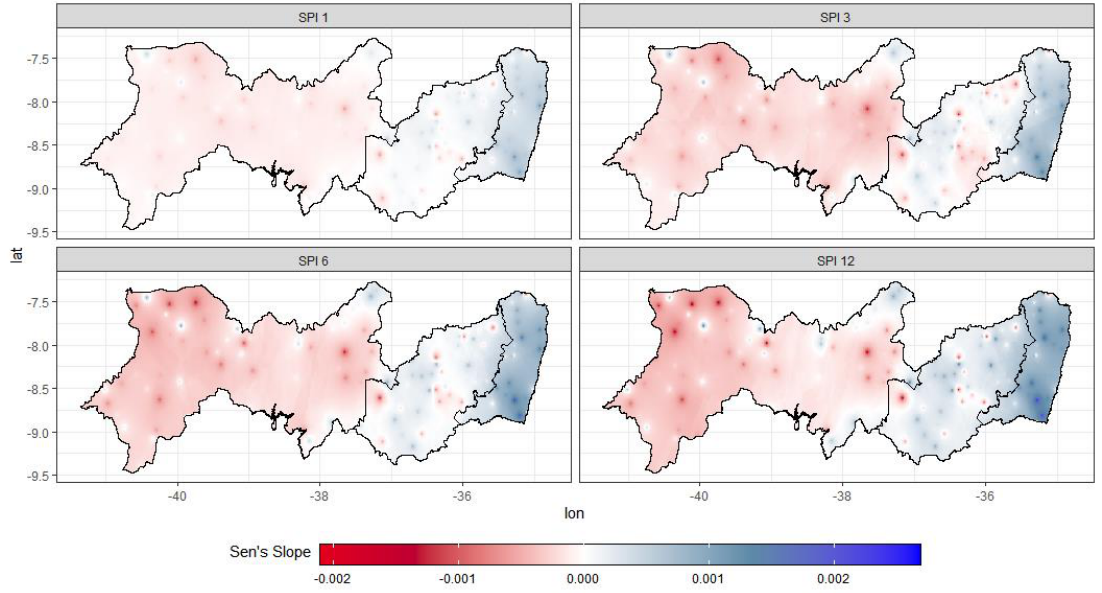
Figure 6. Spatial distribution of Sen’s slope, interpolated across the Pernambuco state.